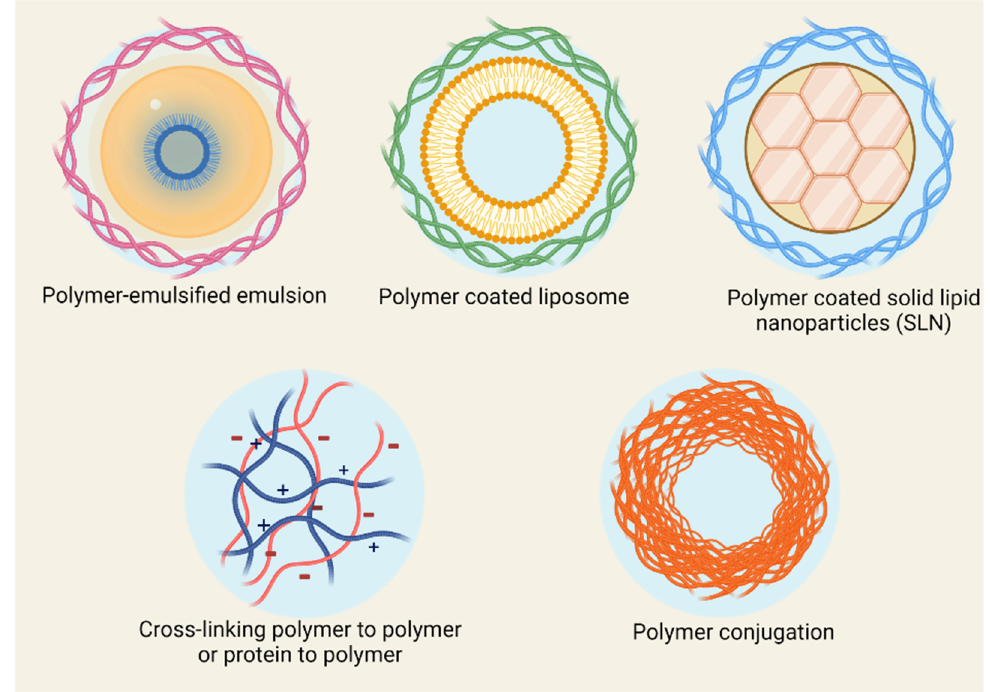
Figure 3. Polymer-based antibiotic delivery systems.